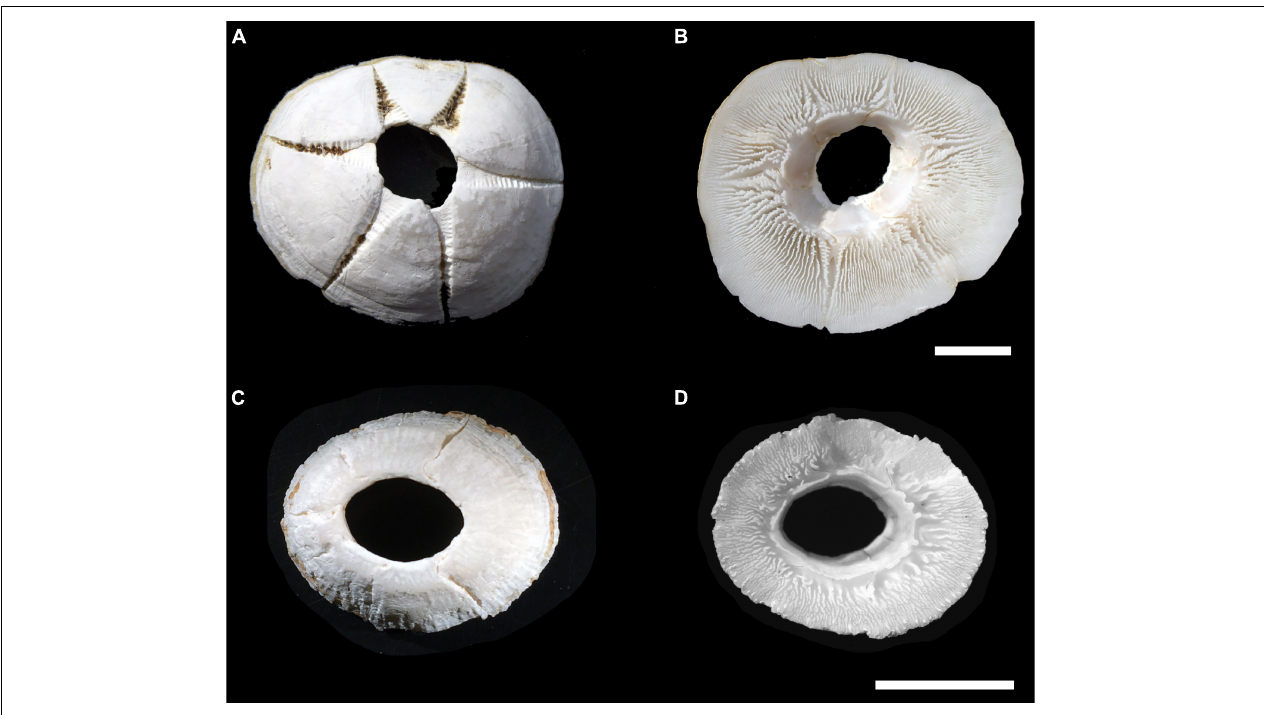
FIGURE 3 | The scute-attaching turtle barnacles: Chelonibia testudinaria collected from a green sea turtle in Japan (specimen courtesy of Hiroyuki Suganuma), apical view (A) and basal view (B) ; and C. caretta collected from a hawksbill sea turtle in Barbados (specimen courtesy of Marina Fastigi), apical view (C) and basal view (D) . Scale bars = 2